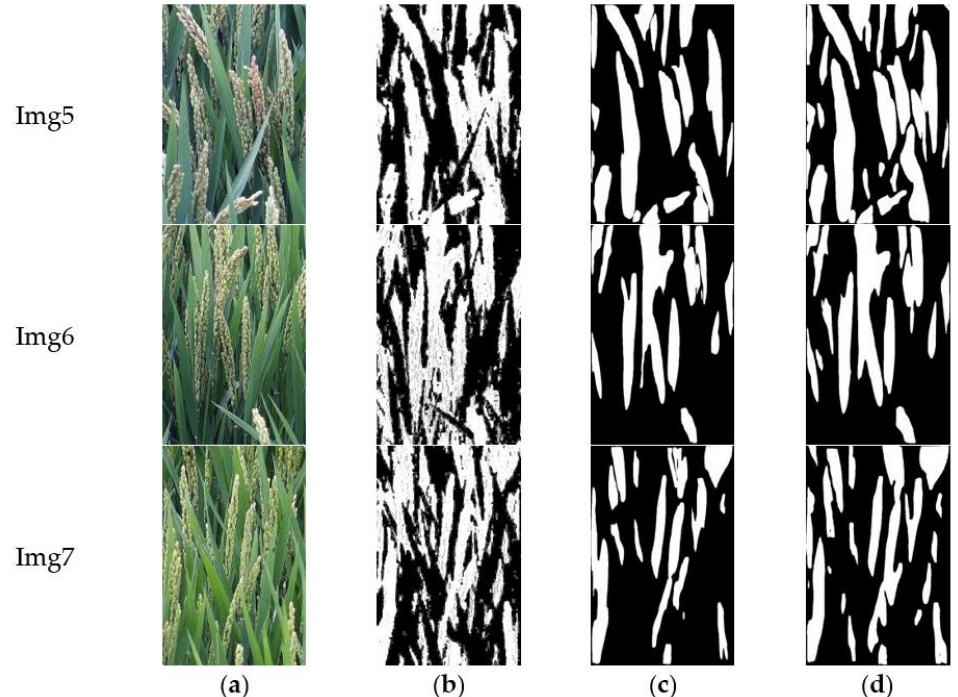
Figure 7. Results from different methods and examples of binarized images: ( a ) Original image; ( b ) Otsu; ( c ) Mask R-CNN; ( d ) Panicle-Mask.